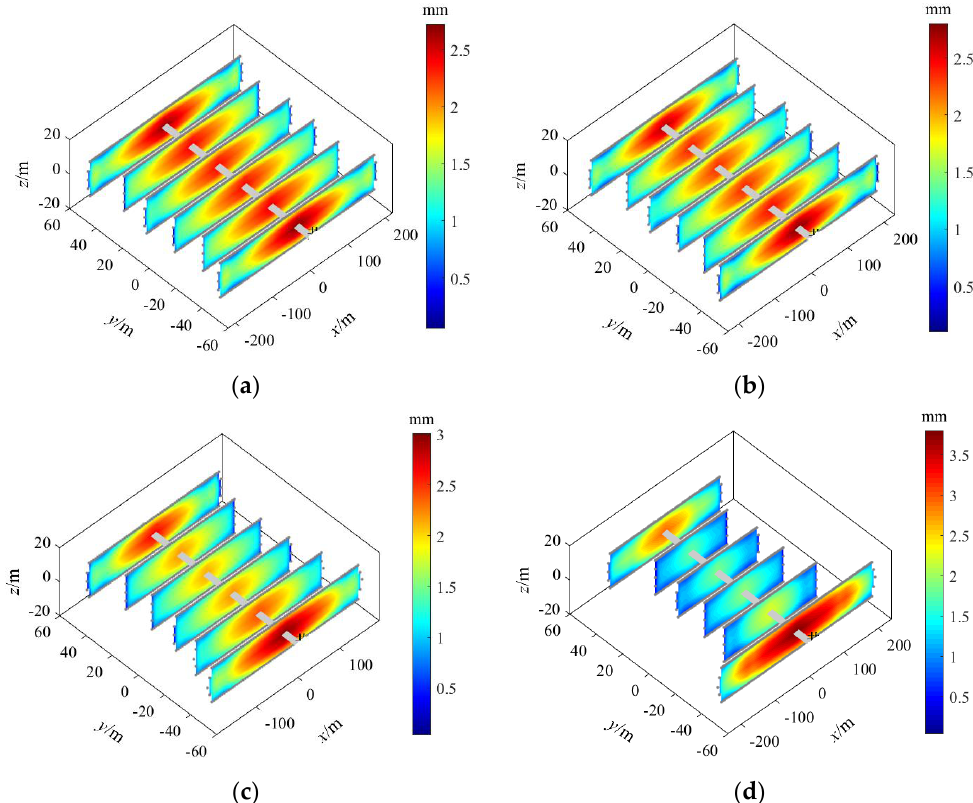
Figure 12. Multi-fracture propagation patterns under different perforation diameters. ( a ) 6 mm; ( b ) 10 mm; ( c ) 14 mm; ( d ) 18 mm.